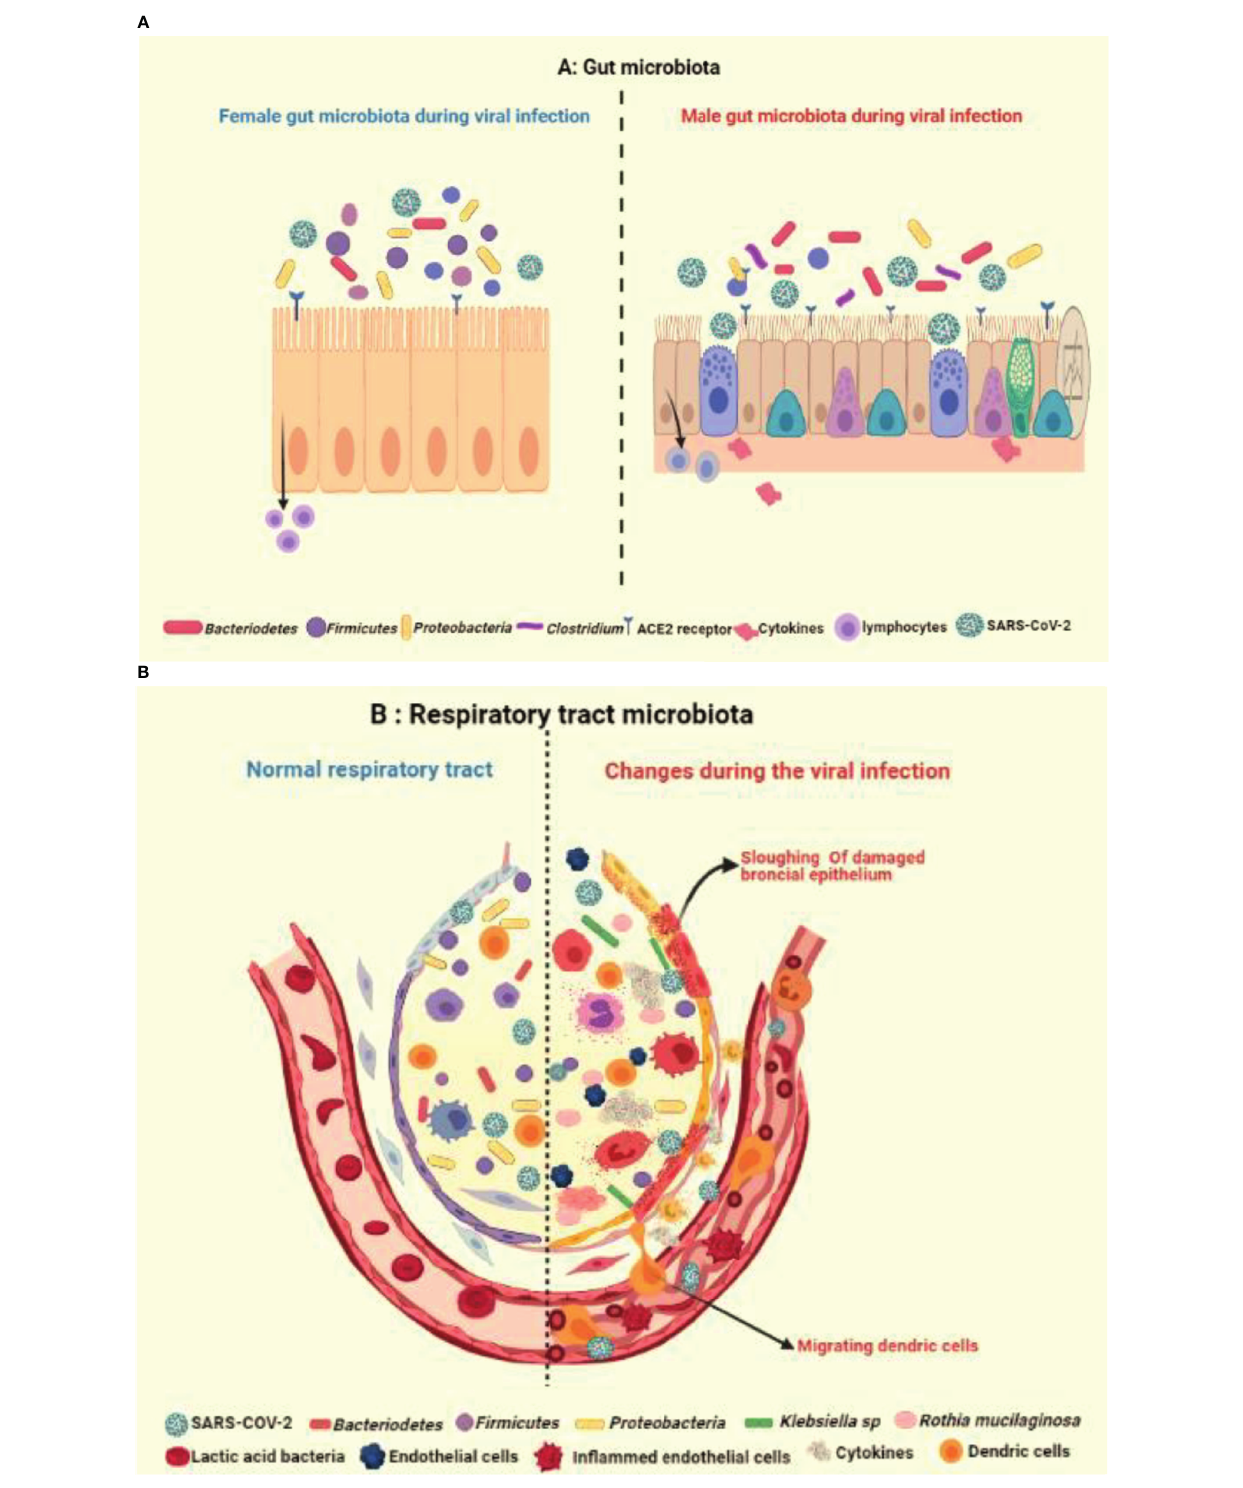
FIGURE 4 | Illustration showing the impact of healthy and unhealthy microbiota on respiratory tract infection. The complex relationship via gut-lung axis might be crucial in determining the vulnerability of respiratory tract to COVID-19, as an outcome of potential variation and crosstalk between (A) healthy gut microbiota with occurrence of fewer Bacteriodetes and (B) respiratory microbiota with prevalence of more Klebsiella and Ruthia sps in virus infected